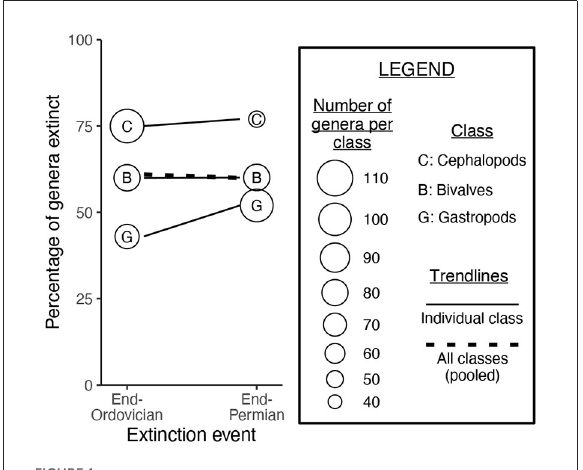
FIGURE1 A paleontological example of Simpson’s paradox, from Wang and Bush (2008). Cephalopods were slightly more likely to go extinct at the end-Permian as compared to the end-Ordovician, and gastropods were much more likely to go extinct. However, when mollusk classes are pooled together, the end-Permian event appears no more severe than the end-Ordovician. This is because cephalopod genera outnumbered gastropod genera at the end-Ordovician, and gastropod genera outnumbered cephalopod genera at the